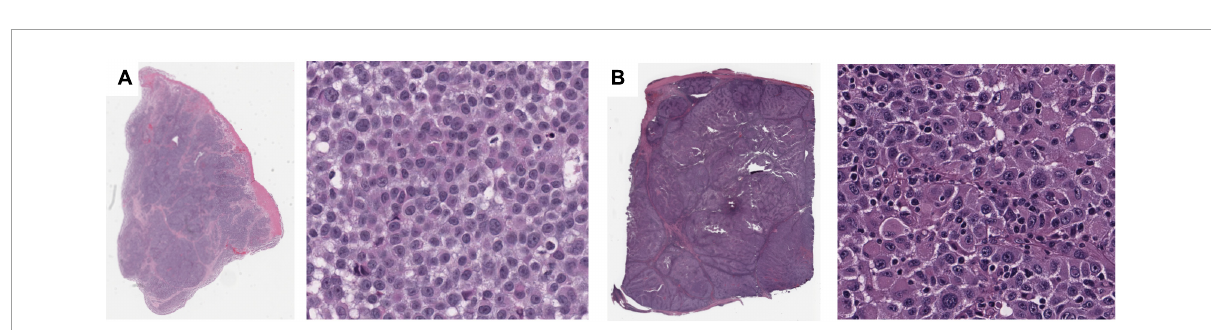
FIGURE4 Feature visualization, Maximum Delaunay distance bin 4 . At high power, (A) specimen TCGA-FR-A20 S, melanoma cells of dense/intermediate packing. (B) Specimen TCGA-ER-A19S, melanoma cells of very dense proliferation, going through stages of necrosis, and immune